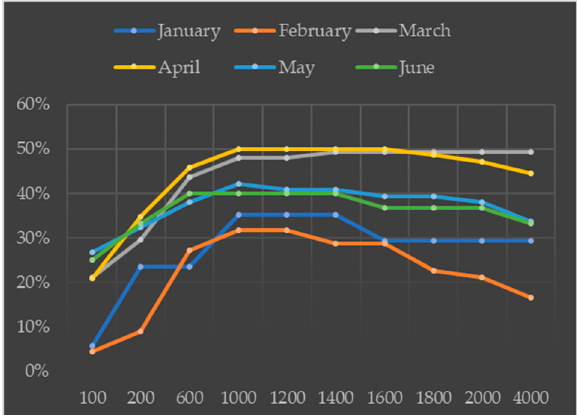
Figure 14. Sensitivity of AnisDM to similarity smoothness parameter ℎ.